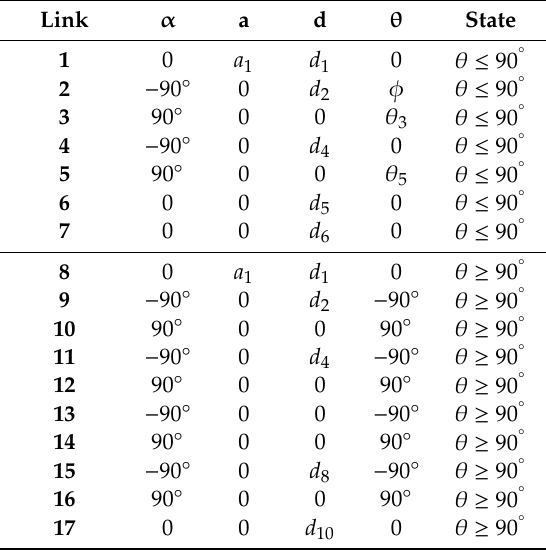
◦ ◦ ) and stage II ( θ ≥ 90 ).